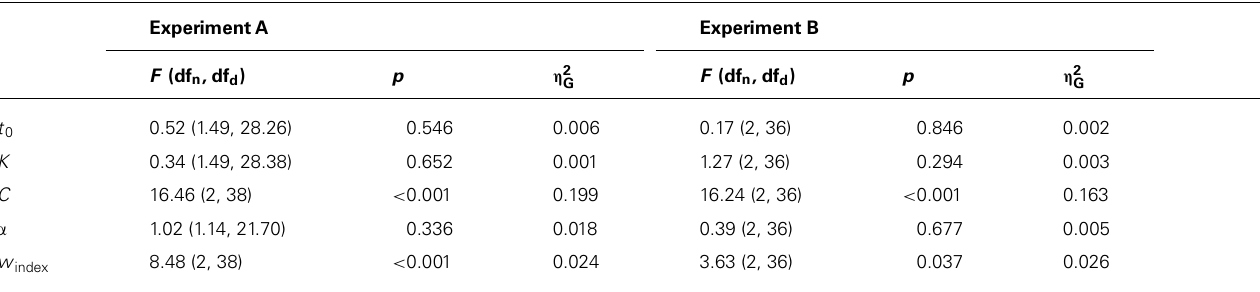
Table 2 |Analyses of variance of the attentional components for the three conditions. ExperimentA Experiment